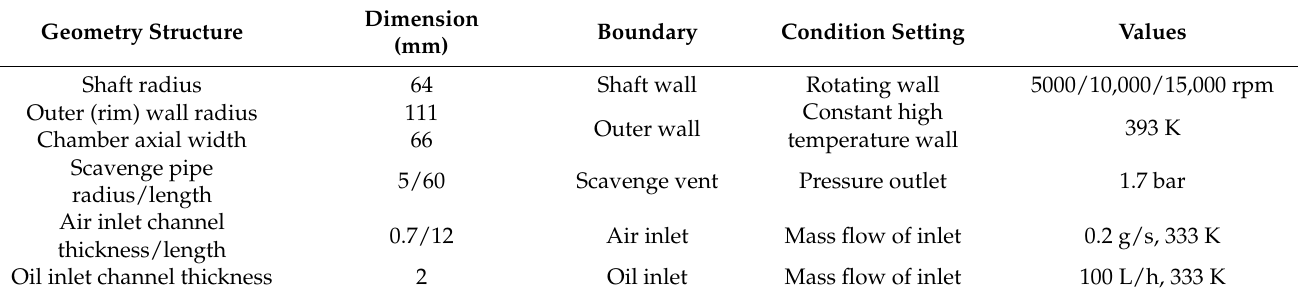
Table 1. Geometric dimensions and boundary conditions.